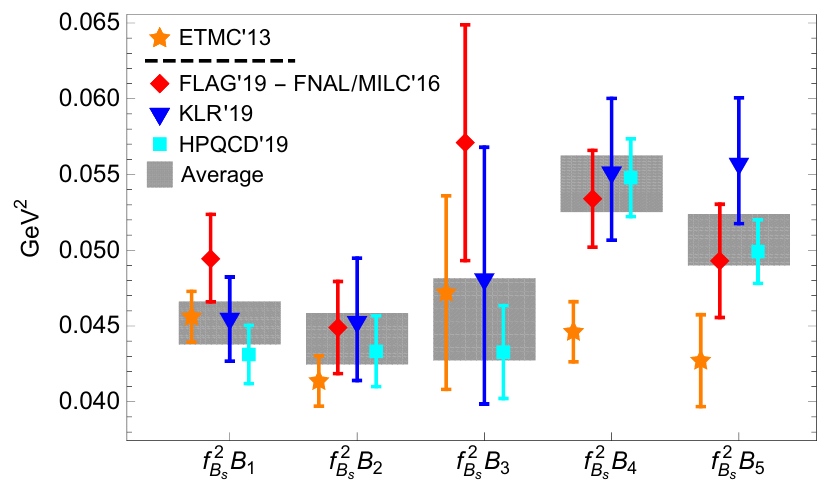
Figure 3 . Comparison of non-perturbative determinations of the matrix elements for B the scale (cid:22) = (cid:22) m ( (cid:22) m ). We show the ETMC ’13 values in orange, the FLAG 2+1 average [13] for b b b the operator Q together with the FNAL/MILC ’16 results [12] for the other operators in red, the 1 sum rule values [24] in blue and the HPQCD ’19 results [25] in cyan. The gray rectangles indicate the weighted averages of the (cid:12)rst three